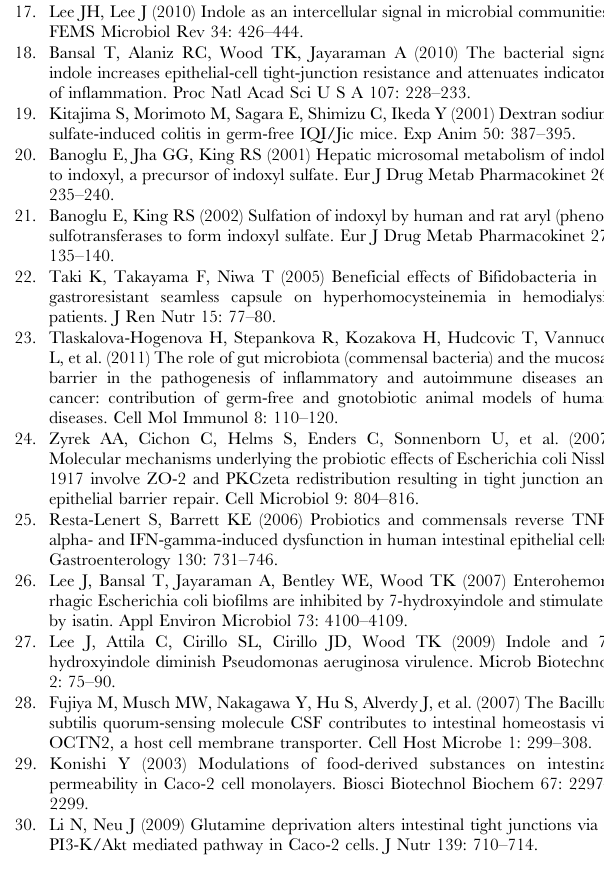
Table S1 Primers list used in this study.